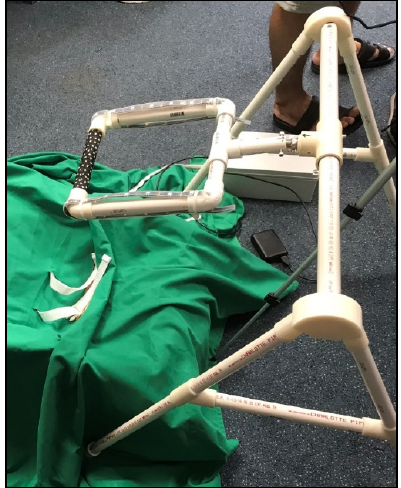
Figure 6. Early rendition of the bar toy with LED light strip on the suspension frame.